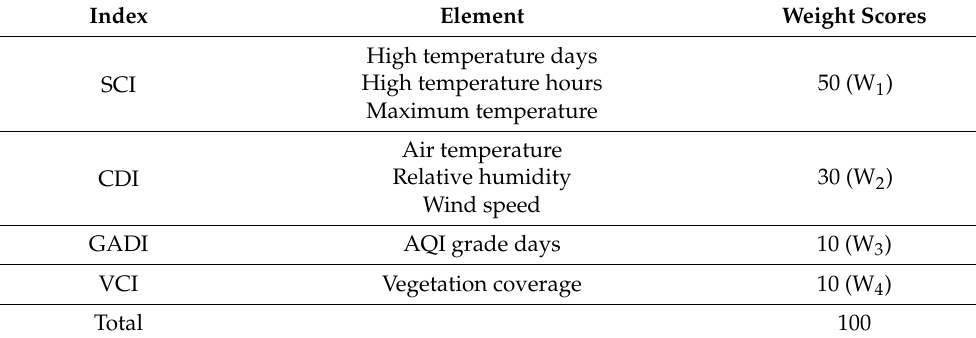
Table 1. Weight scores of summer climate suitability